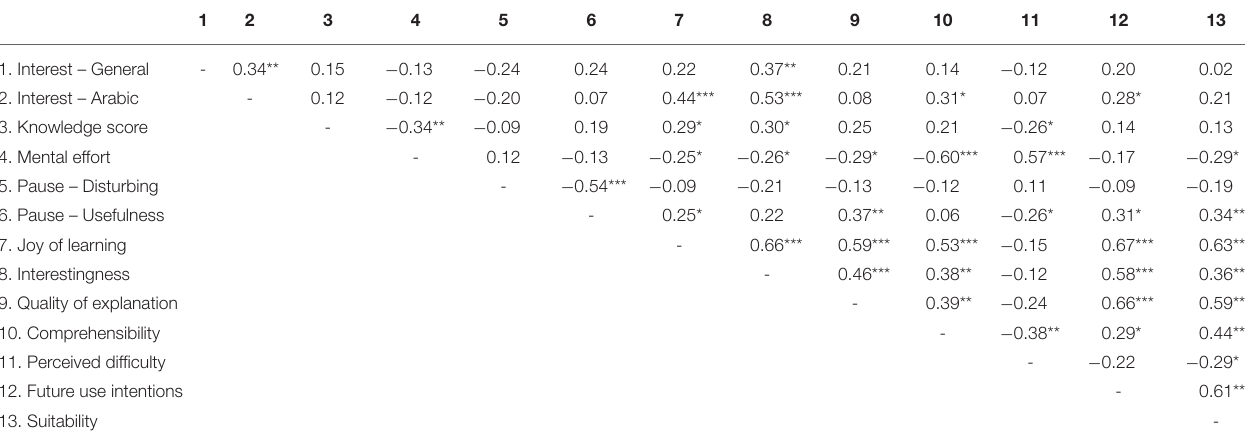
TABLE 2 | Correlations between the different